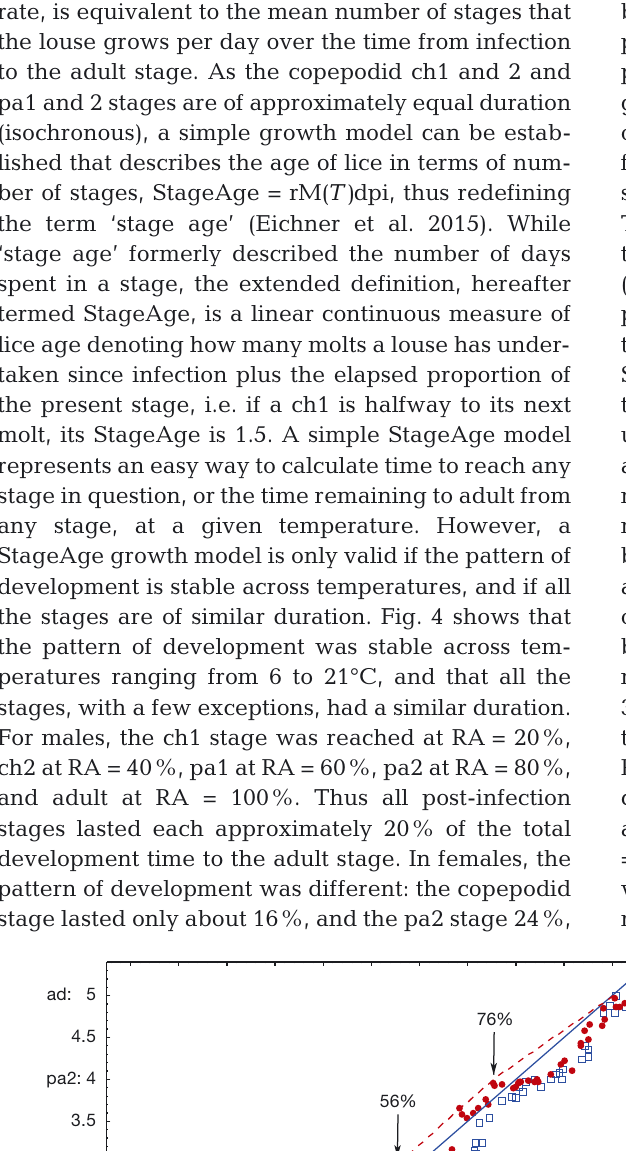
Fig. 4. Mean number of molts (MnM) for male ( h ) and female ( d ) Lepeophtheirus salmonis vs. relative age (RA = % of days post infection until adult) for all samples in the range from 6 to 21°C. Arrows indi- cate the relative age at which the major- ity of females reach ch1, ch2, pa1 and pa2 stages respectively. Predicted StageAge of the slow developers (solid blue line); corrected StageAge for females (red dashed line). These lines provide the means to graphically translate an ob- served MnM value to RA and vice